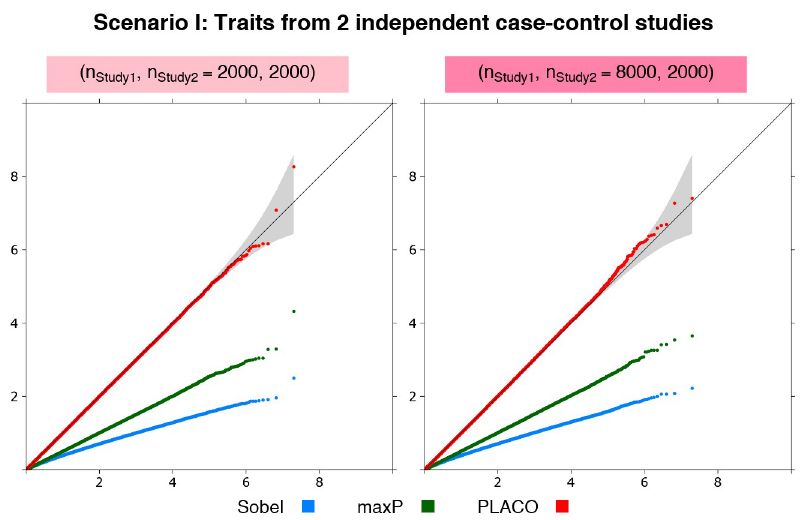
Fig 1. Scenario I: QQ plots for pleiotropic analysis of null data on traits from 2 independent case-control studies. Observed( − log 10 p-values) are plotted on the y-axis and Expected( − log 10 p-values) on the x-axis. Either each study has 1, 000 unrelated cases and 1, 000 unrelated controls, or Study 1 is 4 times that of Study 2, where Study 2 has 1, 000 unrelated cases and 1, 000 unrelated controls. Type I error performance of tests of pleiotropic effect of a genetic variant on the 2 traits is based on 9.99 million null variants with genetic effects that are either { β 1 = 0 = β 2 } or { β 1 = 0, β 2 = log (1.15)} or { β 1 = log(1.15), β 2 = 0}. The gray shaded region represents a conservative 95% confidence interval for the expected distribution of p-values. P-values � 10 -10 are shown here.